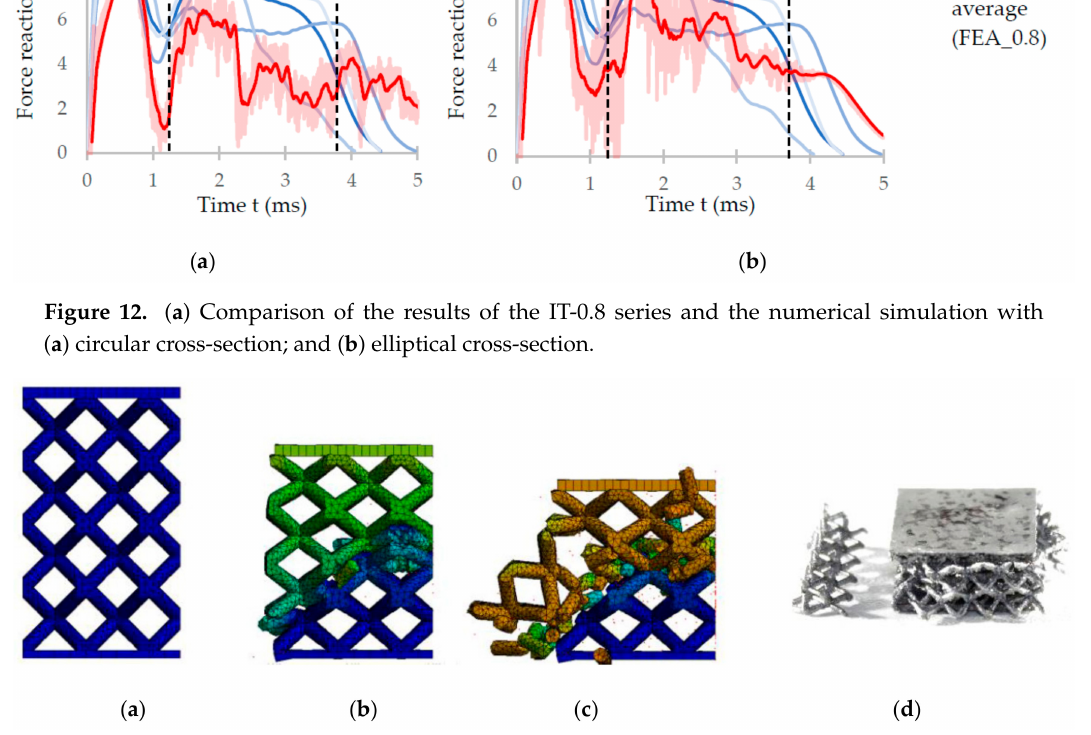
Figure 13. Gradual deformation of the specimen with circular strut cross-section in time—( a ) 0 ms; ( b ) 1.31 ms; ( c ) 3.73 ms; ( d ) real damage of the specimen IT-2 after low-velocity impact